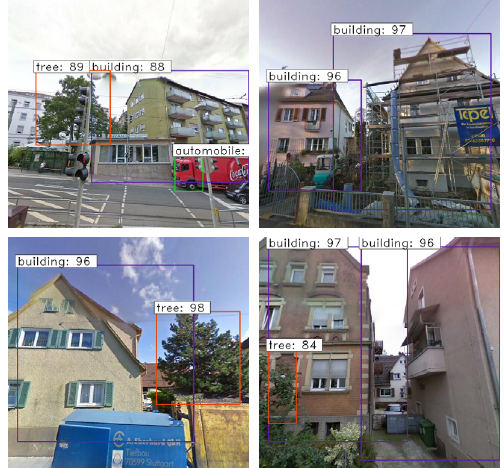
Figure 2. Examples of Faster R-CNN object detection on our extracted Street View